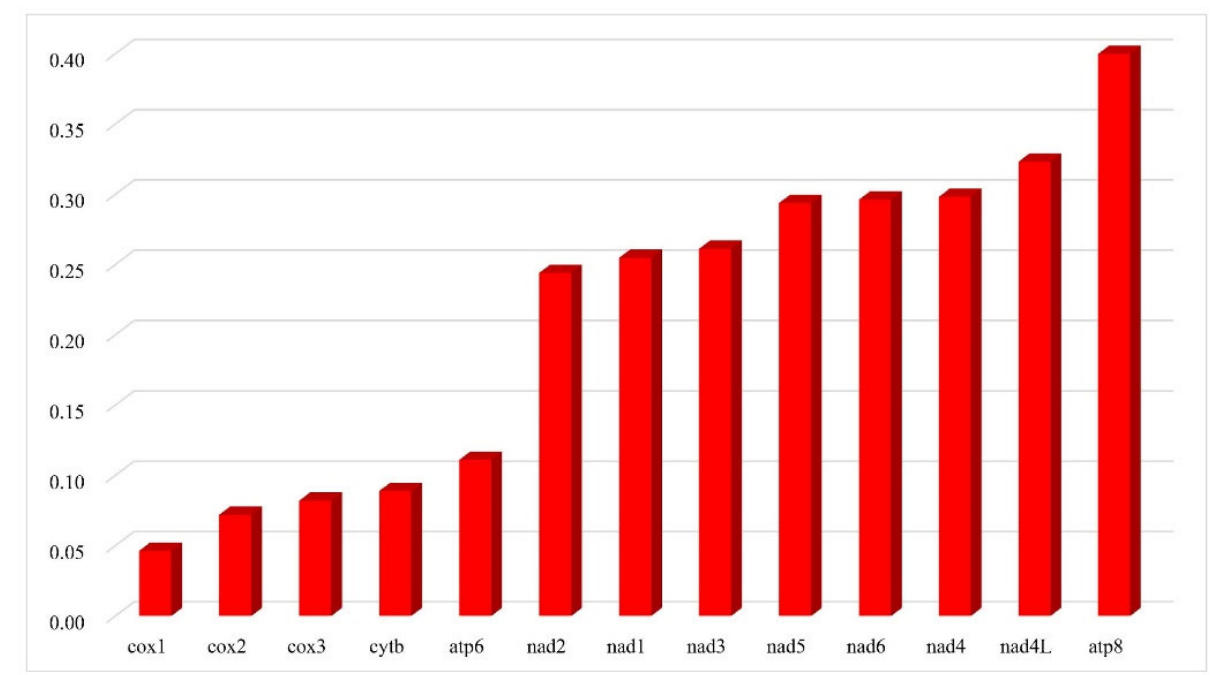
Figure 2. Ka/Ks ratios of 13 protein-coding genes. Ka is the nonsynonymous substitution rate, and Ks is the synonymous substitution rate.